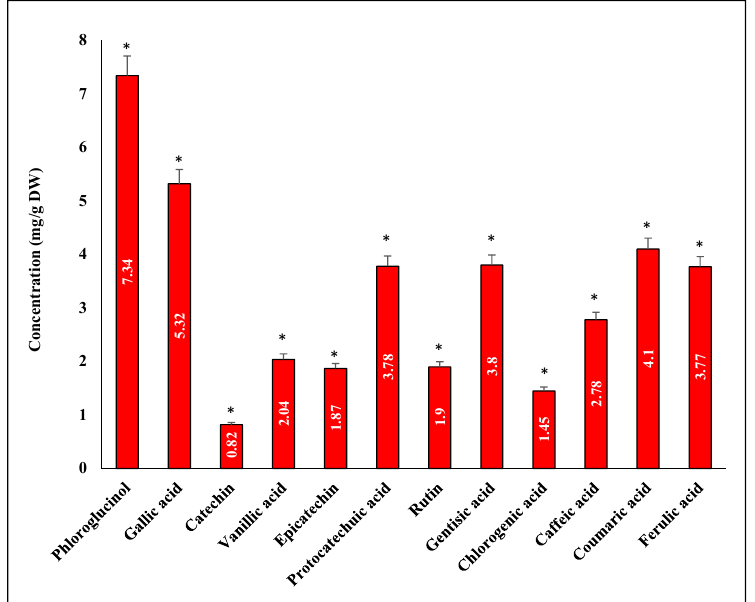
Figure 7. HPLC profile of phenolic compounds in methanol extract of S. dentifolium (highly significant = * p < 0.05, n = 3).